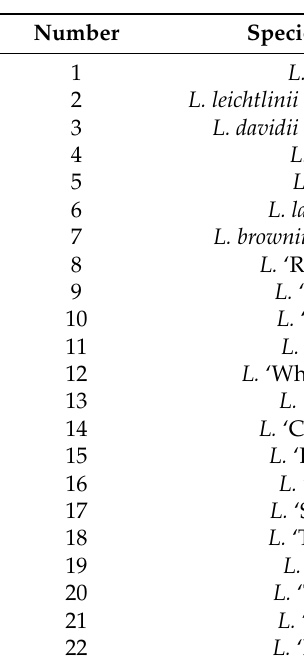
Table 1. Materials used in this